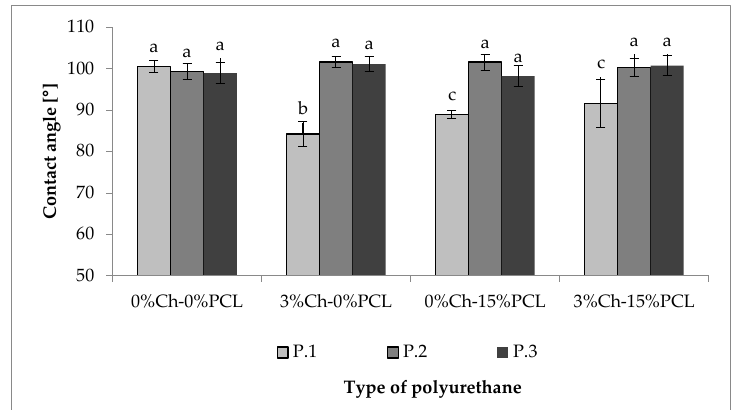
Figure 4. Contact angle of the synthesized PUs. The data are expressed as the mean ± SD (n = 10). Bars with different letters (a–c) indicate significant differences ( p < 0.05).